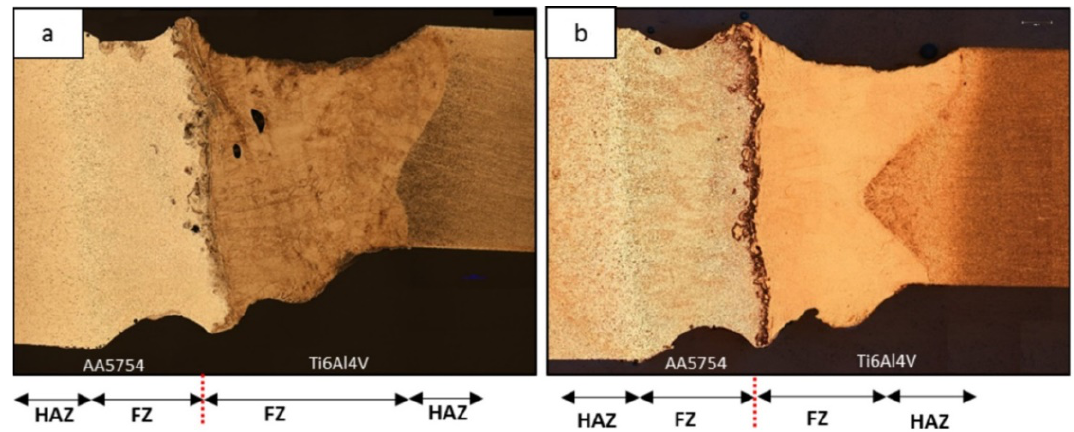
Figure 14. Macrostructure of the two joints: ( a ) 72 J/mm, ( b ) 36 J/mm [62].